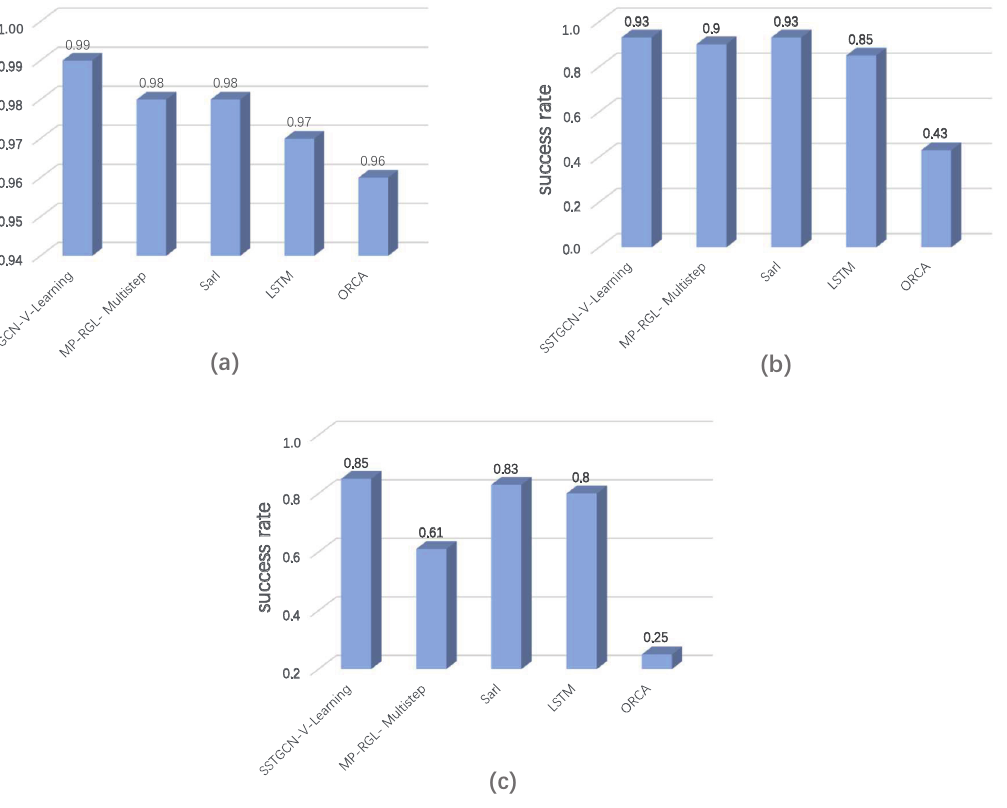
Figure 6. Navigation success rate of related strategies in different scenarios. ( a ) shows the navigation success rate when the number of human is 3. ( b ) shows the navigation success rate when the number of human is 5. ( c ) shows the navigation success rate when the number of human is